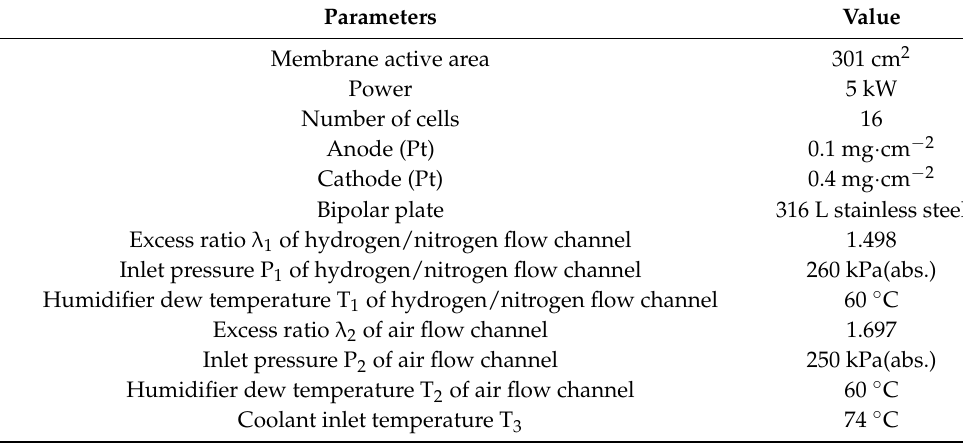
Table 1. Stack parameters and operating parameters.